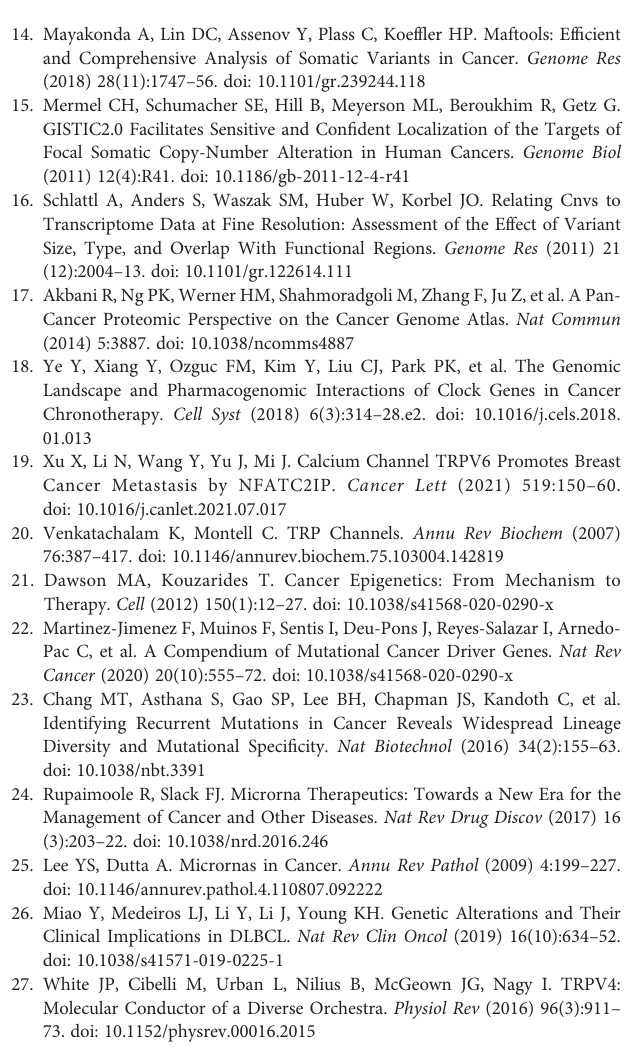
Supplementary Figure 1 | Differential mRNA expression of all data between paired normal and tumor samples in the TCGA database. Signi fi cant differences data are color-labeled, while genes without signi fi cant differences are in transparent color. Supplementary Figure 2 | Survival analysis of TRPV2, TRPV3, TRPV4, and TRPV6. Supplementary Figure 3 | Overall survival associated with mutations of TRPV5 channel-related regulators across cancer subtypes. Supplementary Figure 4 | The percentage of pathway activation and inhibition of TRPV channel regulators. Supplementary Figure 5 | Evaluation of TRPV6 mRNA expression in MDA-MB- 231 and A549 cells treated with shRNA (Student ’ s t test, *** P <